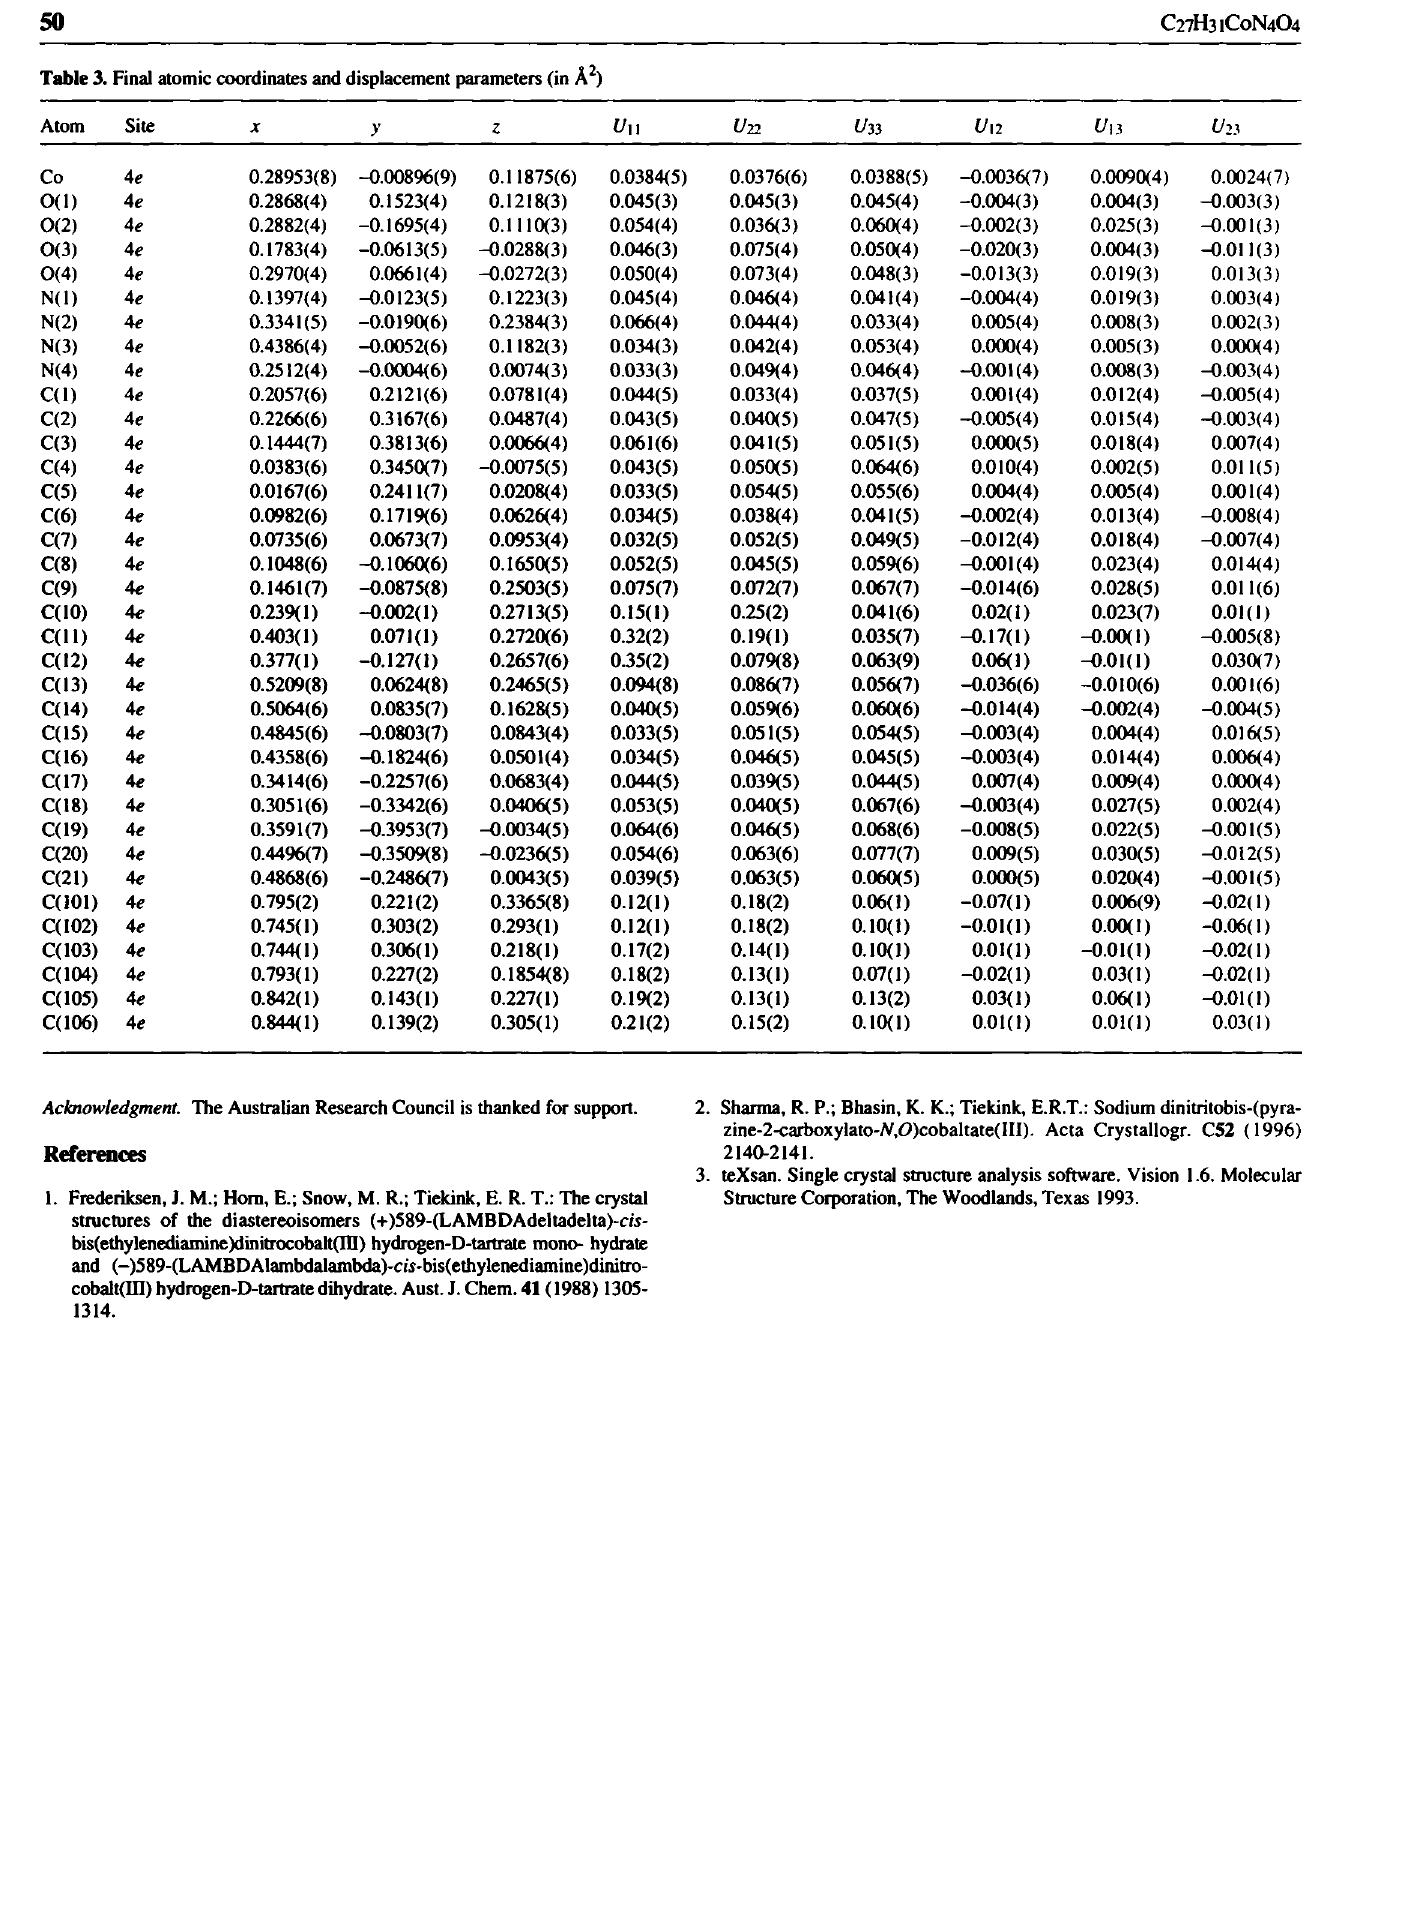
Table 3. Final atomic coordinates and displacement parameters (in Â^) Atom